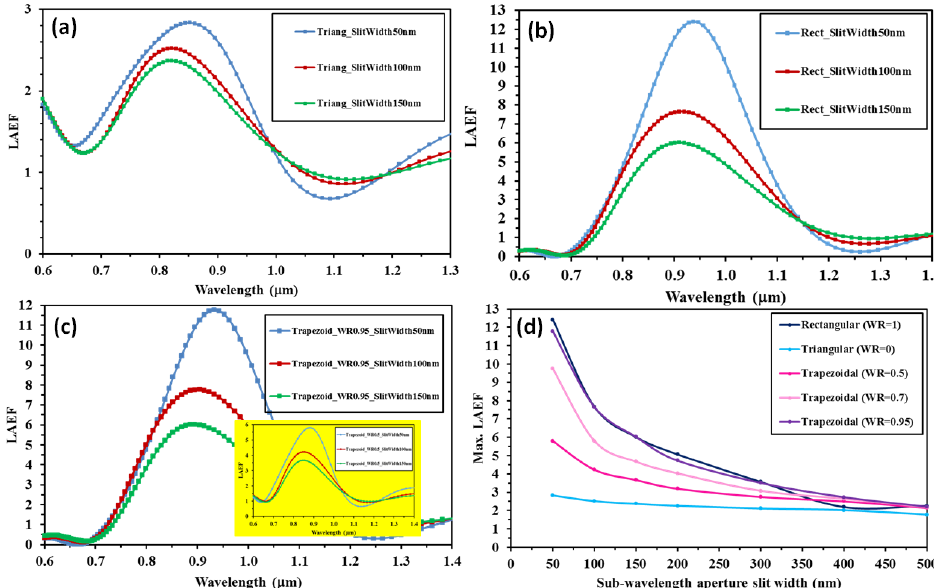
Figure 7. Light absorption enhancement factor (LAEF) spectrum of MSM-PD observed for various grating shapes with different slit-width, Traingel shape ( a ), Rectangular shape ( b ), Trapezoidal shape ( c ), and comparison of slit-width dependent maximum LAEF achieved for different nanograting structures [76]. ( d )